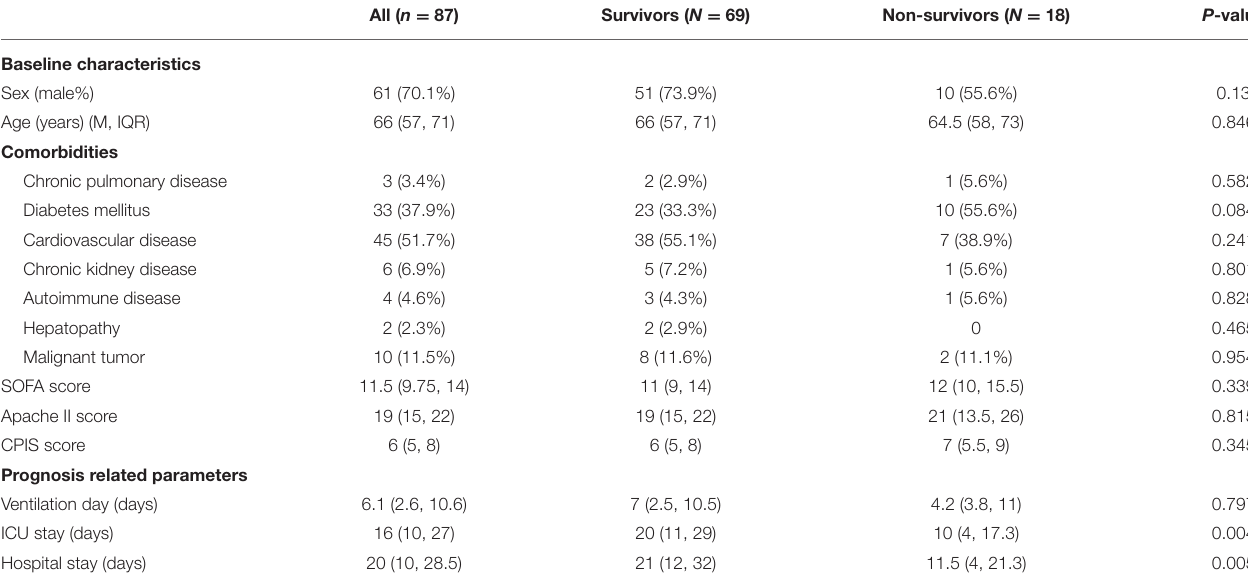
TABLE 1 | Baseline characters of ARDS patients caused by A. baumannii pneumonia. All ( n = 87) Survivors ( N = 69) Non-survivors ( N = 18) P